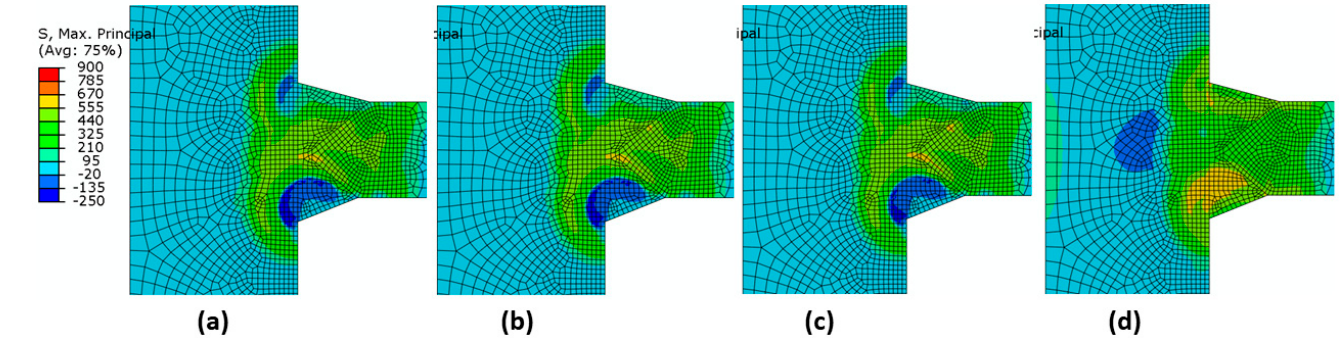
Figure 11 . Max. Principal residual stress in the FE model under different conditions (MPa), (a) Ms = 300 °C, (b) Ms = 350 °C, (c) Ms = 400 °C, and (d) no phase transformation.